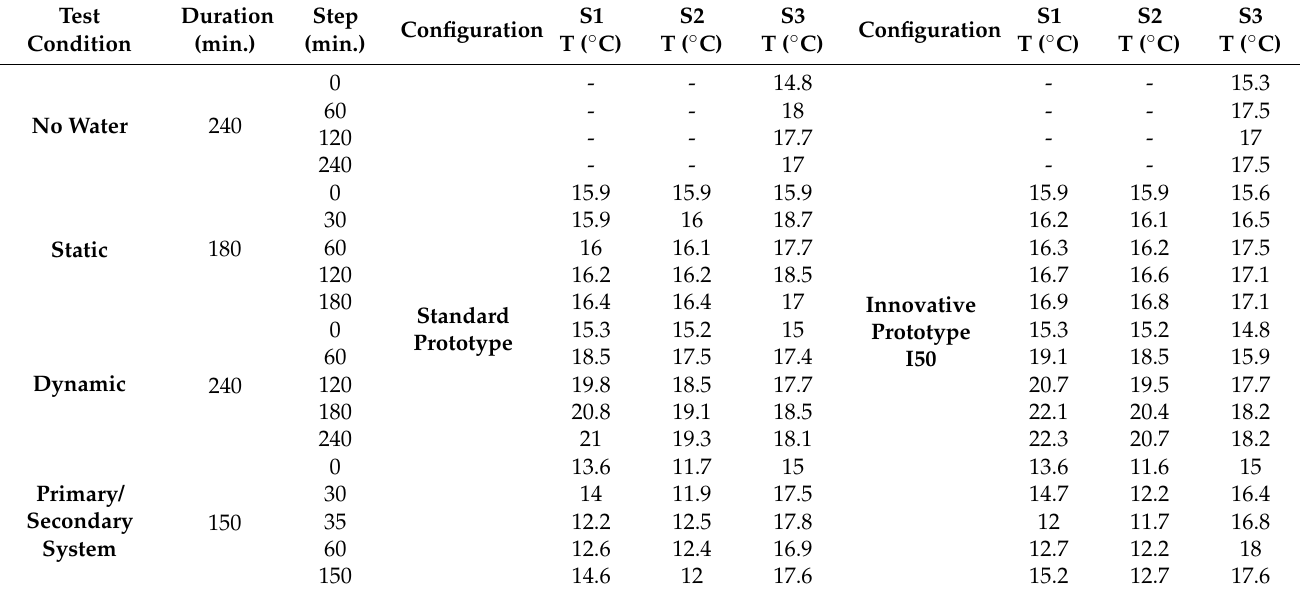
Table 1. Experimental data resulting from tests on the geo-exchange prototype